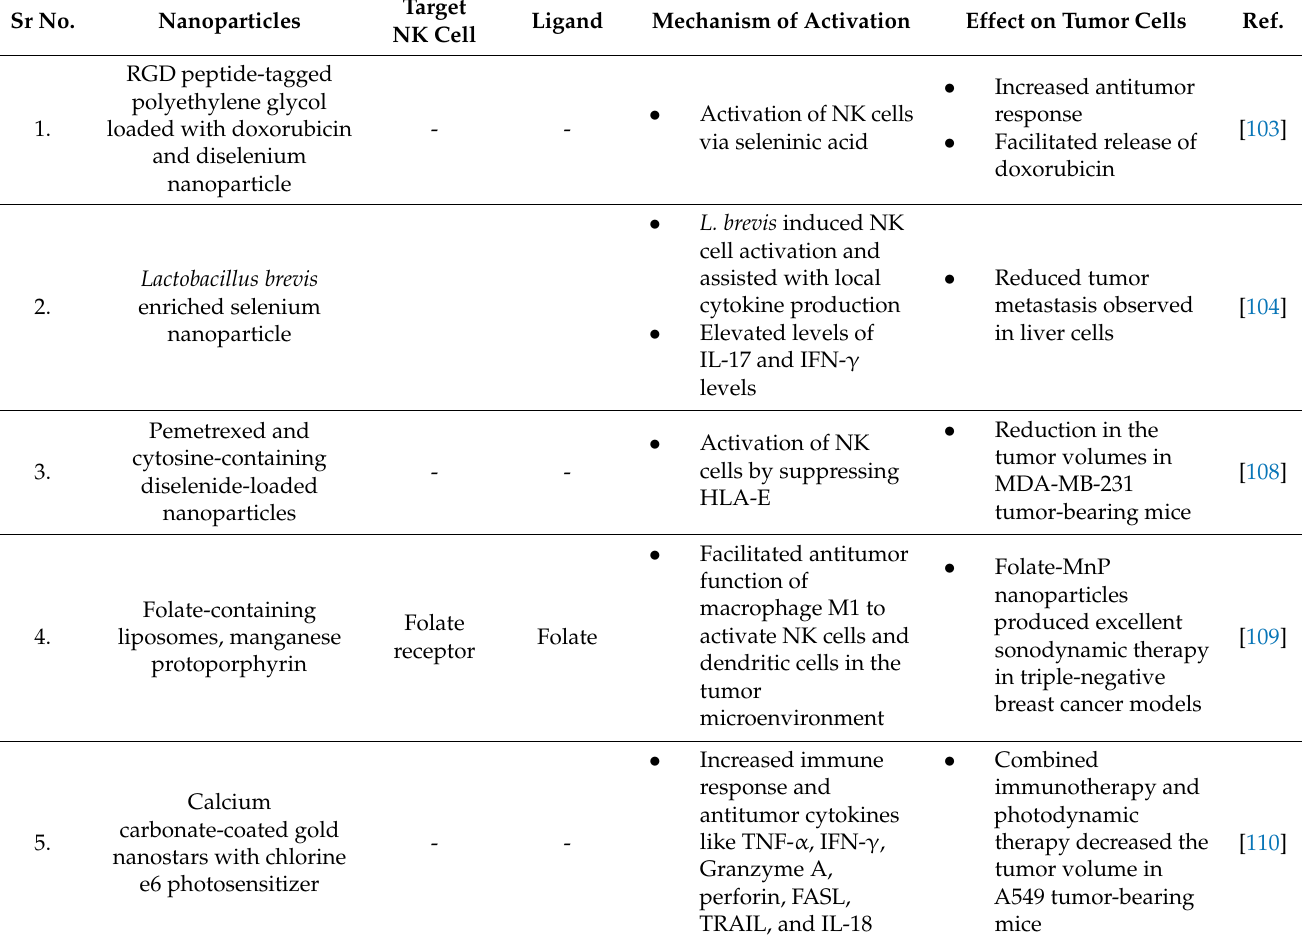
Table 2. Comprehensive information on nanoparticle-based immunomodulation for enhancing NK cell